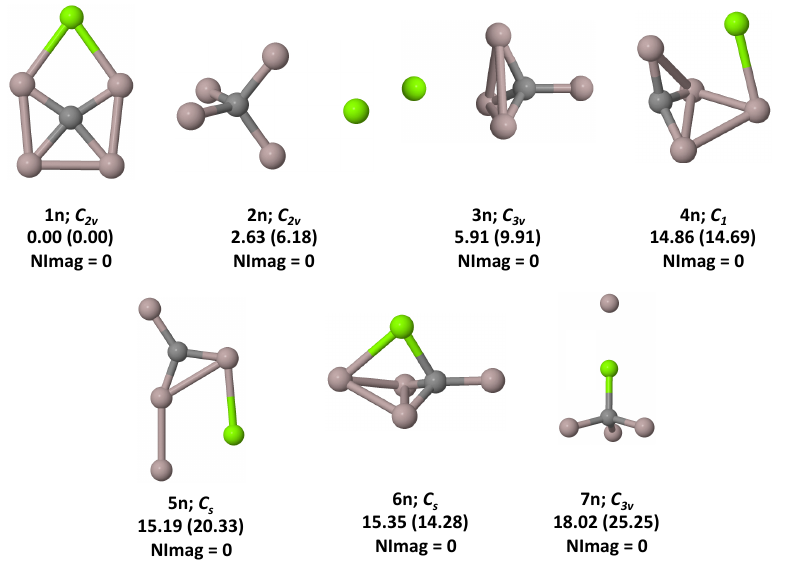
Figure 2. Low-lying isomers of CAl 4 Mg on the singlet PES. Relative energies including ZPVE correction (in kcal mol − 1 ) are calculated at the ω B97XD/6-311++G(2d,2p) level. Relative energies obtained at the CBS-QB3 level are shown in parentheses. Number of imaginary frequencies (NImag) obtained for each stationary point are indicated underneath the